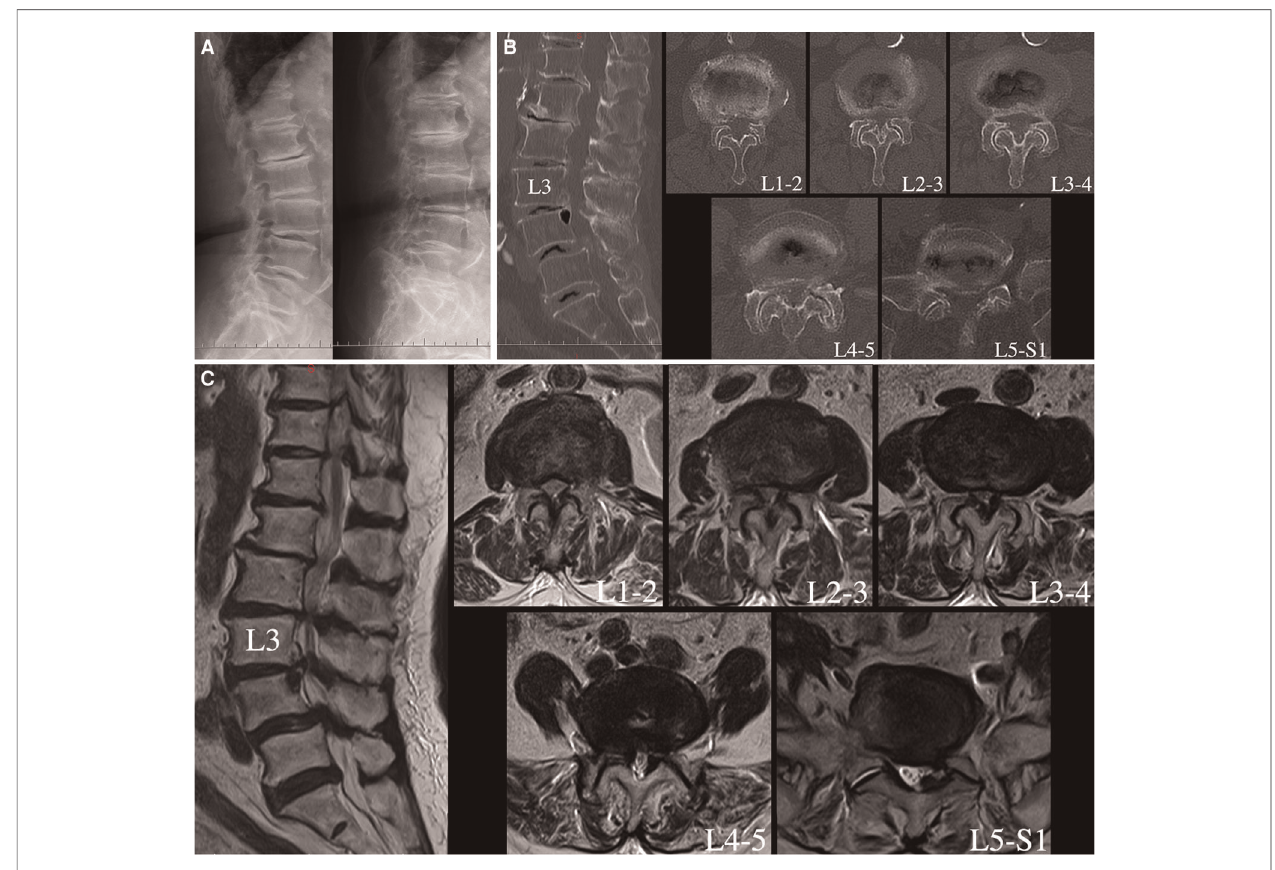
FIGURE 1 | Flexion and extension lateral lumbar X-ray radiograph demonstrating relative dynamic stability at all lumbar segments ( A ). Lumbar CT showing hyperplasia and cohesion of the facet joints, ossi fi cation of the ligamentum fl avum and multilevel stenosis of the lateral recesses and central canals ( B ). Sagittal and axial T2-weighted lumbar MRI revealing serious central canal stenosis from L1-2 to L4-5, lumbar disc herniation and left lateral recess stenosis at L5-S1 ( C